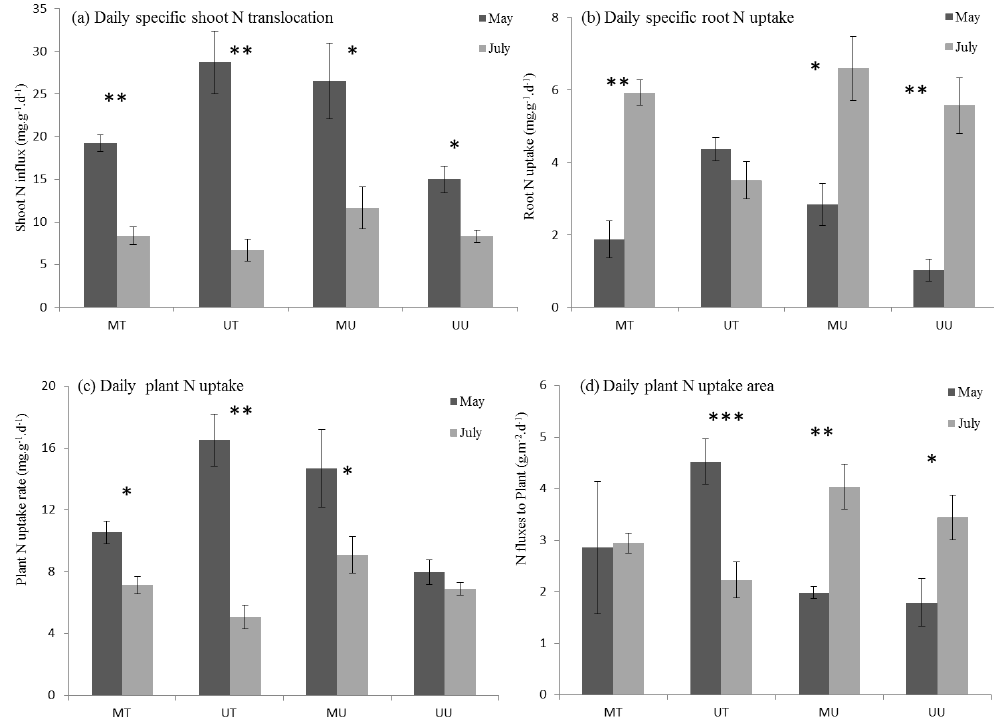
Figure 3. Fig. 3. Differences in plant nitrogen (N) fluxes between the end of snowmelt and the peak biomass in subalpine agricultural grasslands with distinct land uses. The fluxes of nitrogen (N) into (a) aboveground plant tissue, (b) belowground plant tissue are expressed on a per-g- biomass basis. The flux of N into the entire plant per day (c) is expressed on a per-g-biomass basis and (d) on a per-area basis. Uptake of N is calculated from the 15 N concentration and the soil 14 N: 15 N ratio. Data from four 200cm 2 areas per fields were amalgamated to give mean values of three fields per land use ± SE. Statistical analyses were done separately for each land use and stars represent significant differences (* < 0 . 05; ** < 0 . 01 and *** < 0 .